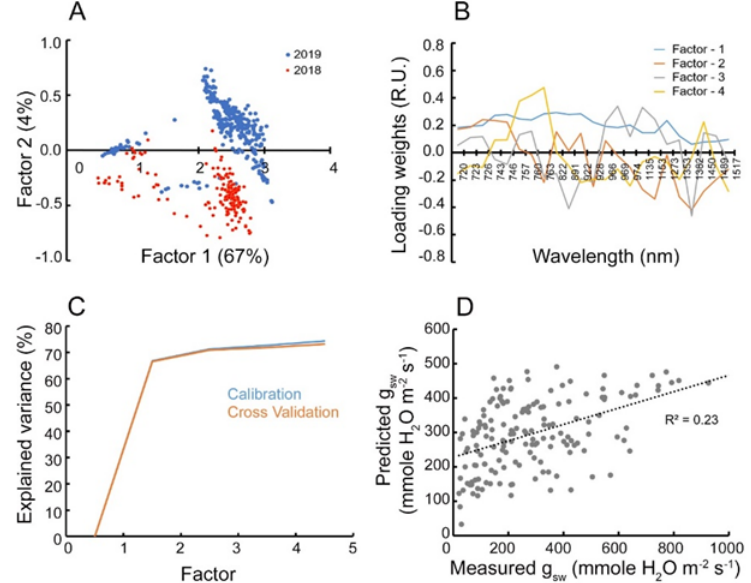
Figure 6. Construction of stomatal conductance index with partial least squares regression. ( A – C ) represent the model construction on 75% of the samples in the data (calibration—494), and ( D ) comparison between the predicted stomatal conductance by the model and the measured stomatal conductance on 25% of the samples (test—164). ( A ) Scores plot of the calibration subset. Only the first two principal components out of total of four are shown. Colors represent the years. ( B ) Loading weights plot of the calibration subset in each of the four principal components of the model and per wavelength selected by the RF algorithm. ( C ) Explained variance of the calibration subset together with a leave-one-out cross validation test on the same subset. ( D ) Coefficient of determination represents the correlation between the predicted and the measured stomatal conductance.